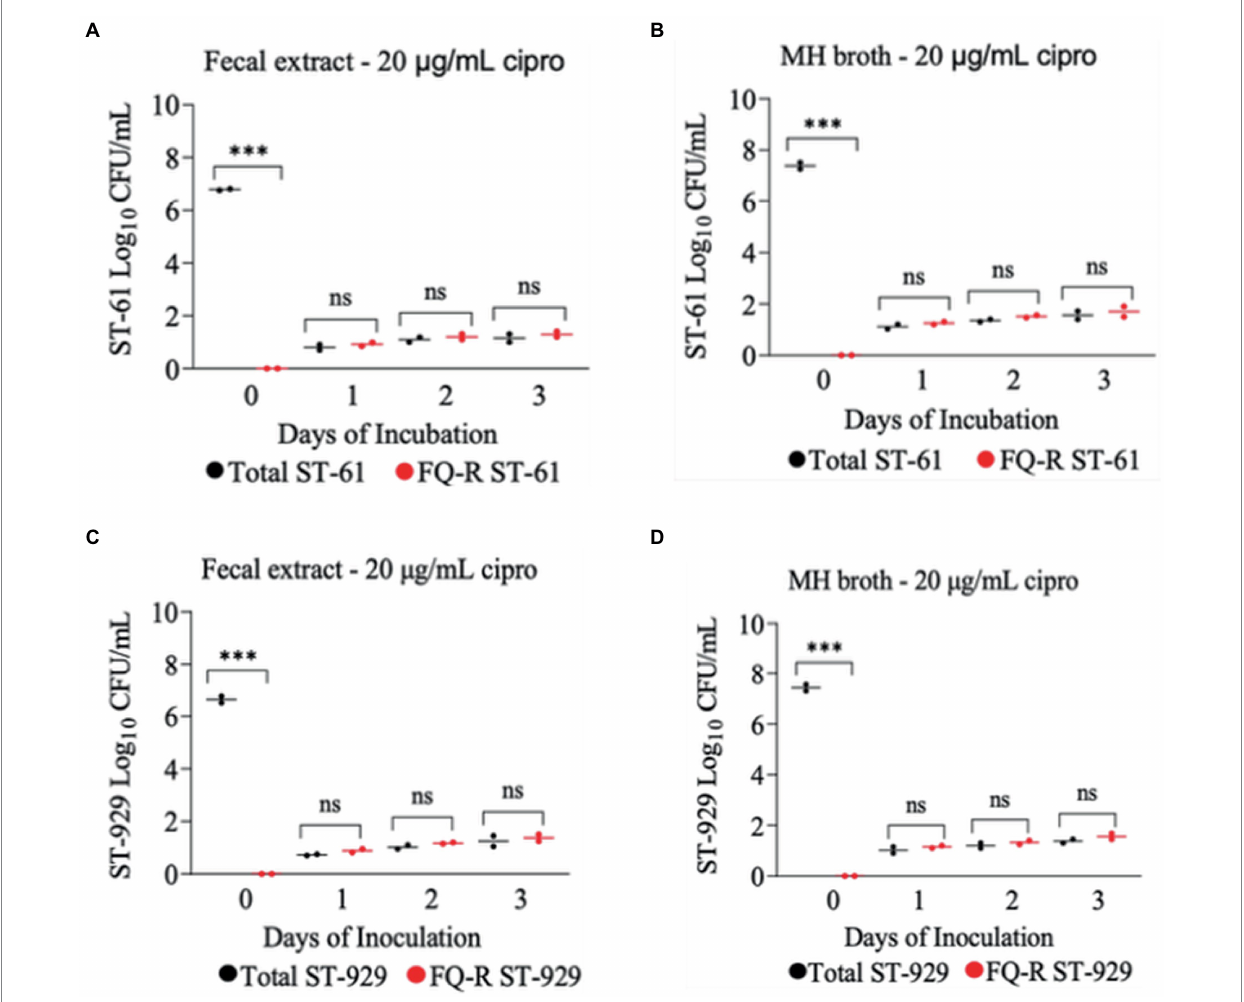
FIGURE 6 Development of FQ-resistant C. jejuni mutants (shown as red dots) from FQ-susceptible strains (ST-61, and ST-929) grown in bovine fecal extract (A,C) and MH broth (B,D) supplemented with 20 μ g/mL of ciprofloxacin. The initial bacterial cell density (day 0) of each inoculum was 10 7 CFU/mL. Black dots denote total (susceptible + resistant) colonies. Each dot represents the log 10 CFU/mL of each strain at a given time (horizontal bars represent the mean log 10 CFU/mL of three replicates). The number of bacterial colonies was measured on days 0, 1, 2, and 3 of incubation. The detection limit of the culture was ~ 4 CFU/mL medium. The experiment was repeated twice, and the results of one representative experiment are